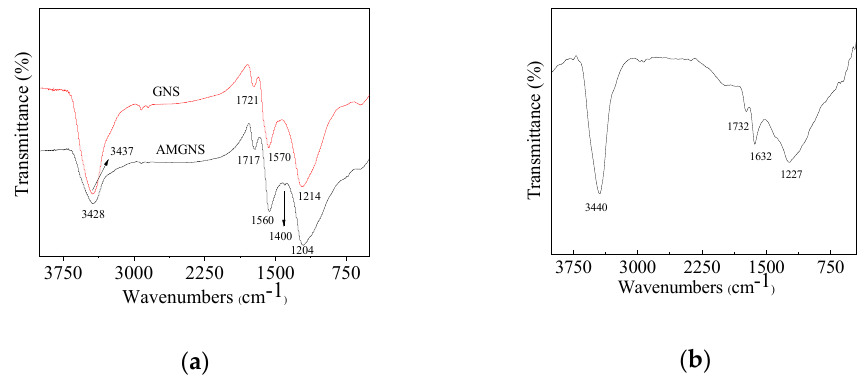
Figure 1. FTIR spectrum of ( a ) GNS and AMGNS; ( b ) CNT after concentrated nitric acid treatment.